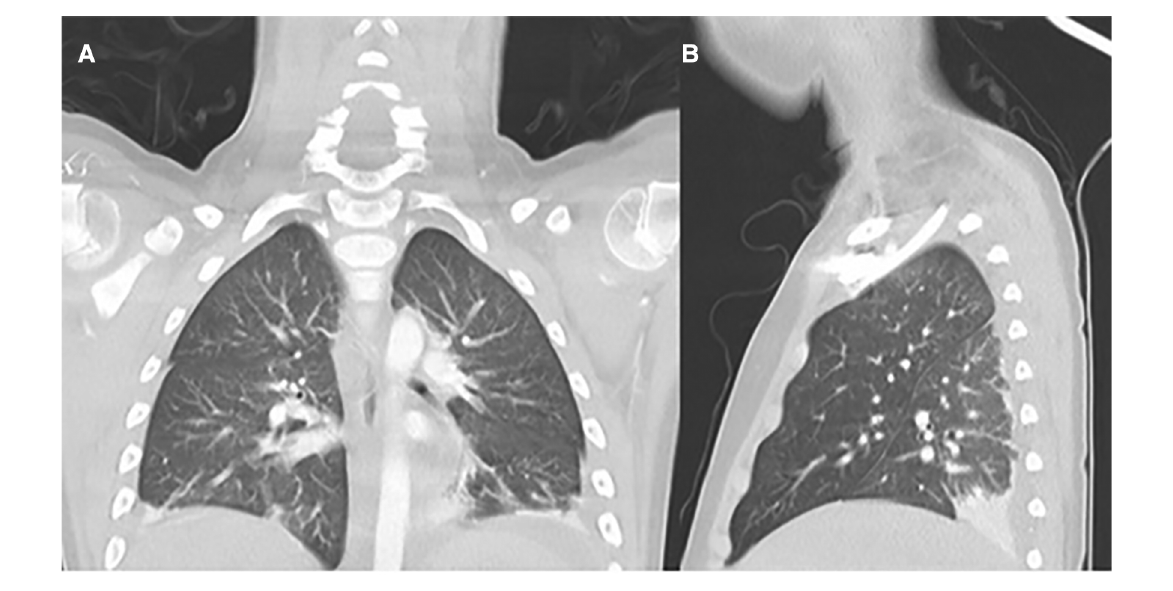
examination was normal, and the blood test and cardiologic assessment with echocardiography also normalized; therefore, the cardioaspirin therapy was stopped.